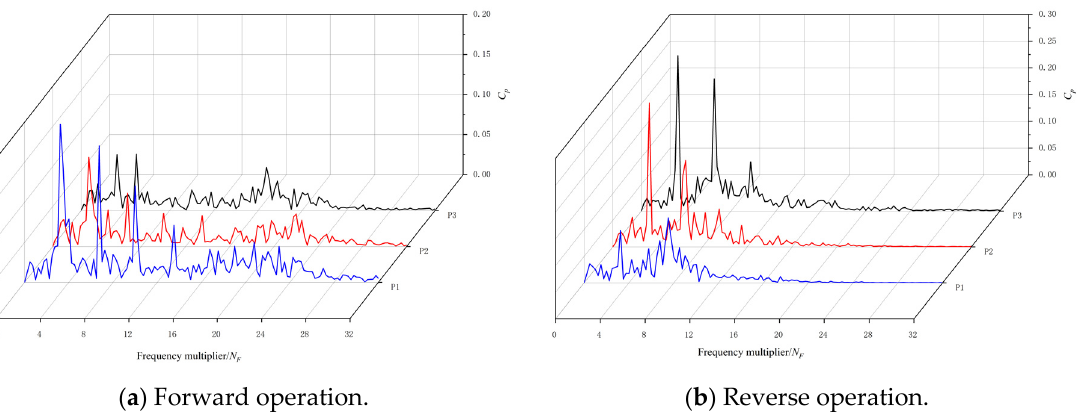
Figure 14. Pressure pulsation distribution of bidirectional axial flow pump in small flow rate of 0.70 Q bep .